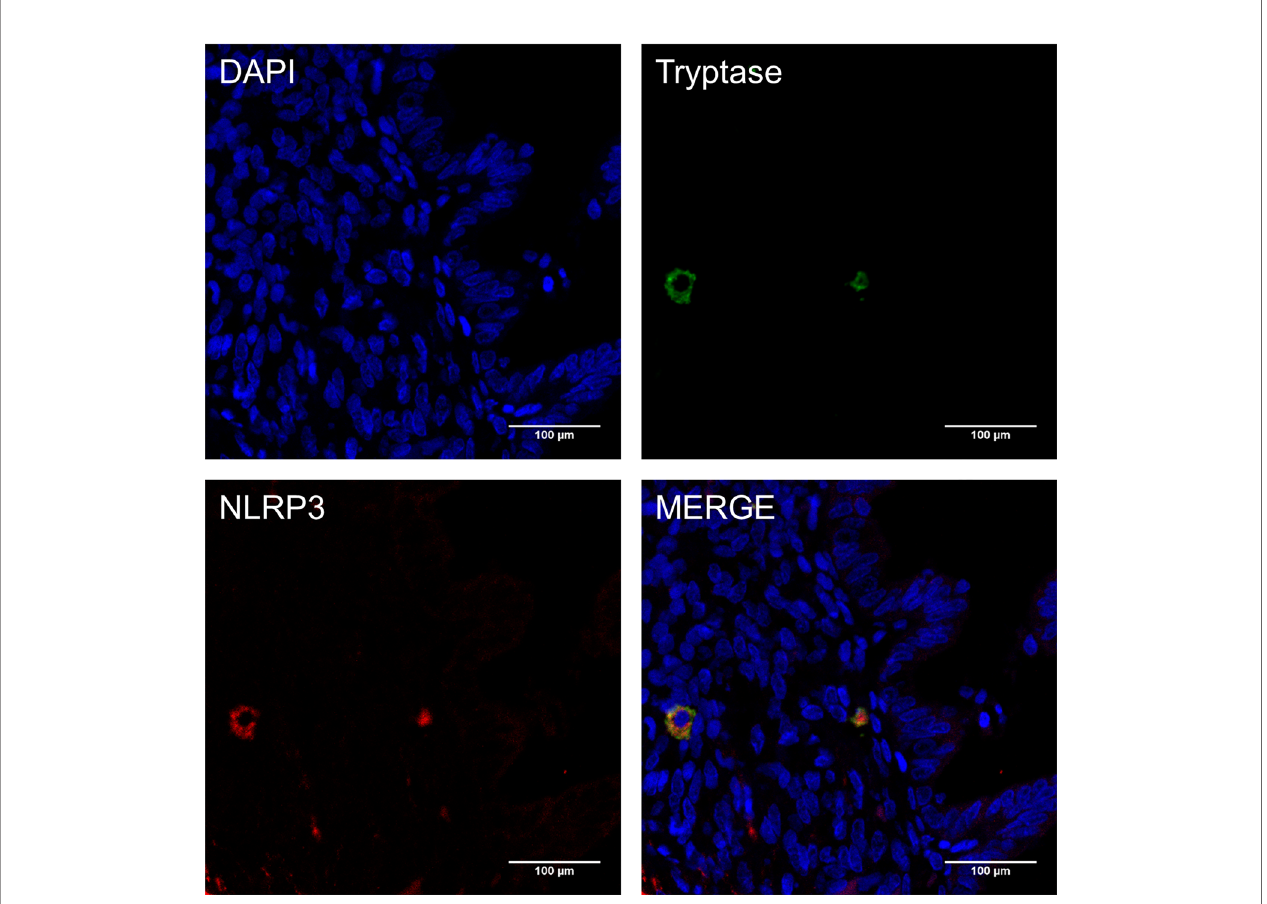
FIGURE 3 | NLRP3 was expressed in mast cells in endometriosis. Immuno fl uorescence double staining for mast cell tryptase (green), NLRP3 (red) and cell nuclei (DAPI, blue) in paraf fi n sections of human ovarian endometriomas specimens (original magni fi cation 800×; scale bars = 100 m